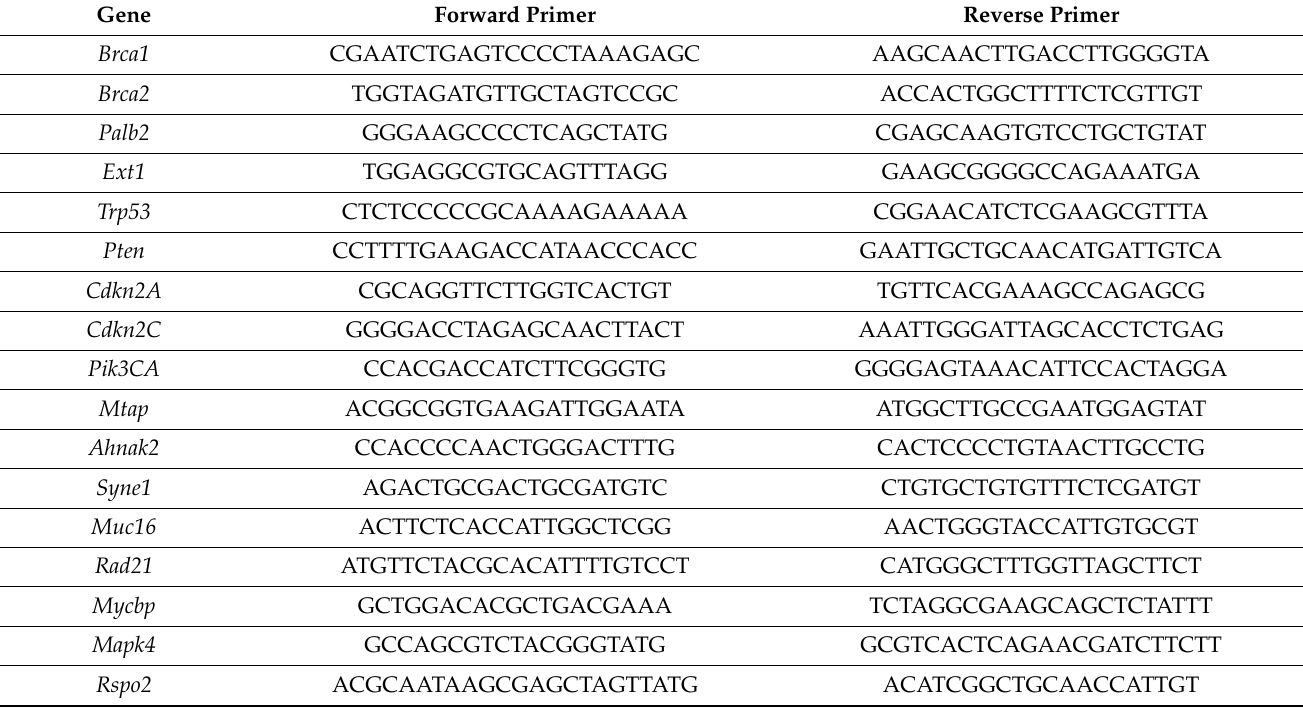
Table 1. qRT-PCR oligonucleotide